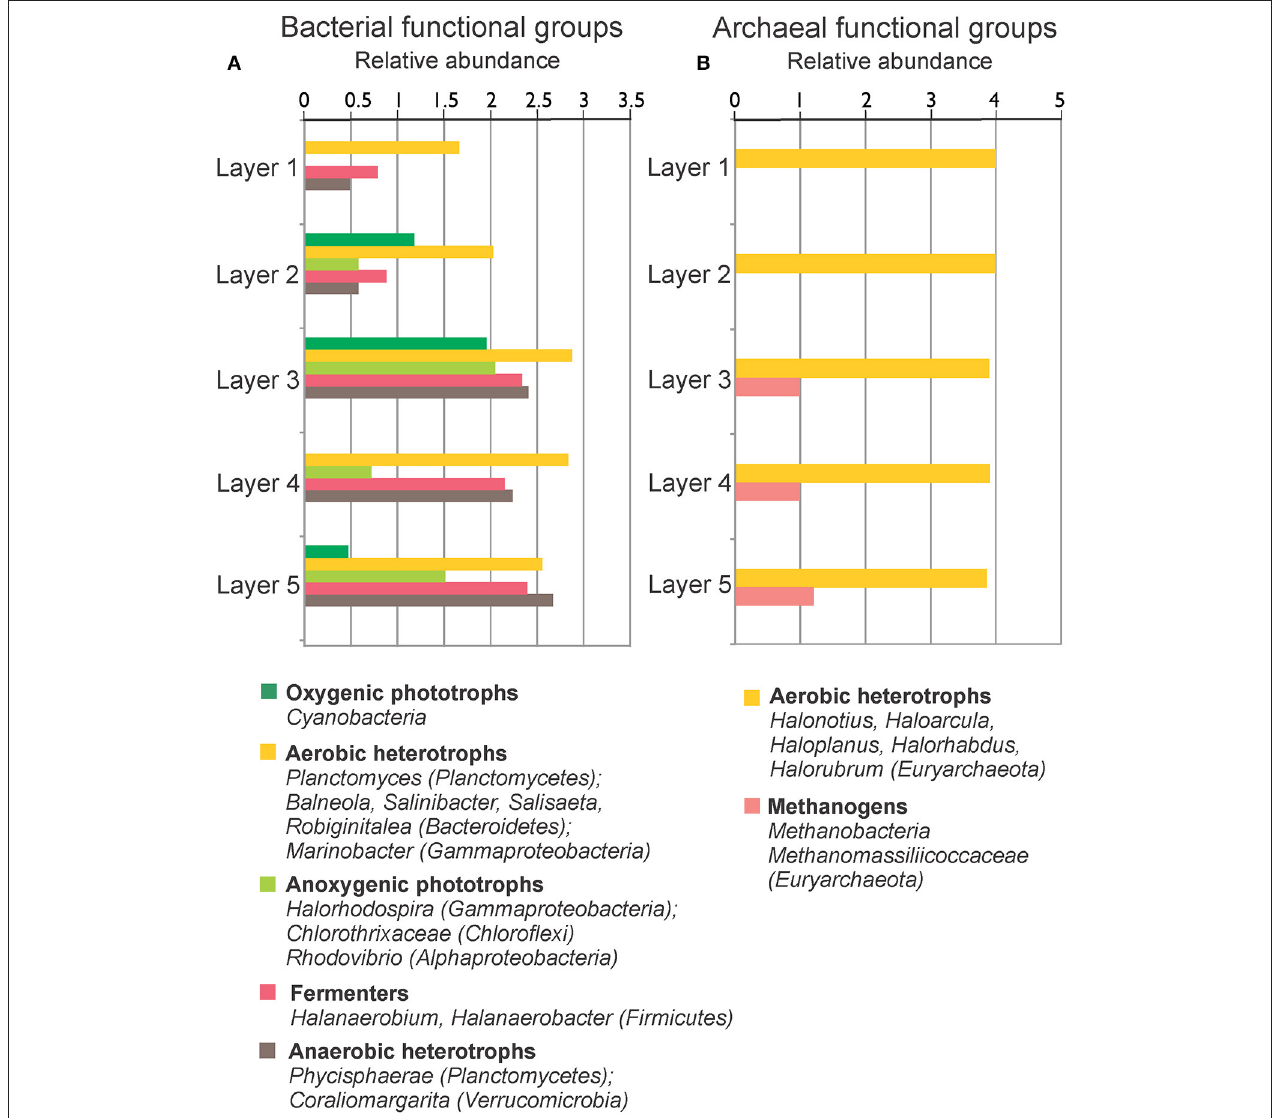
FIGURE 9 | Relative abundance (log 10 base) of bacterial (A) and archaeal (B) functional groups by layers in EVD. Functional groups are formed with the available metabolic information from the microorganisms present in the sample.